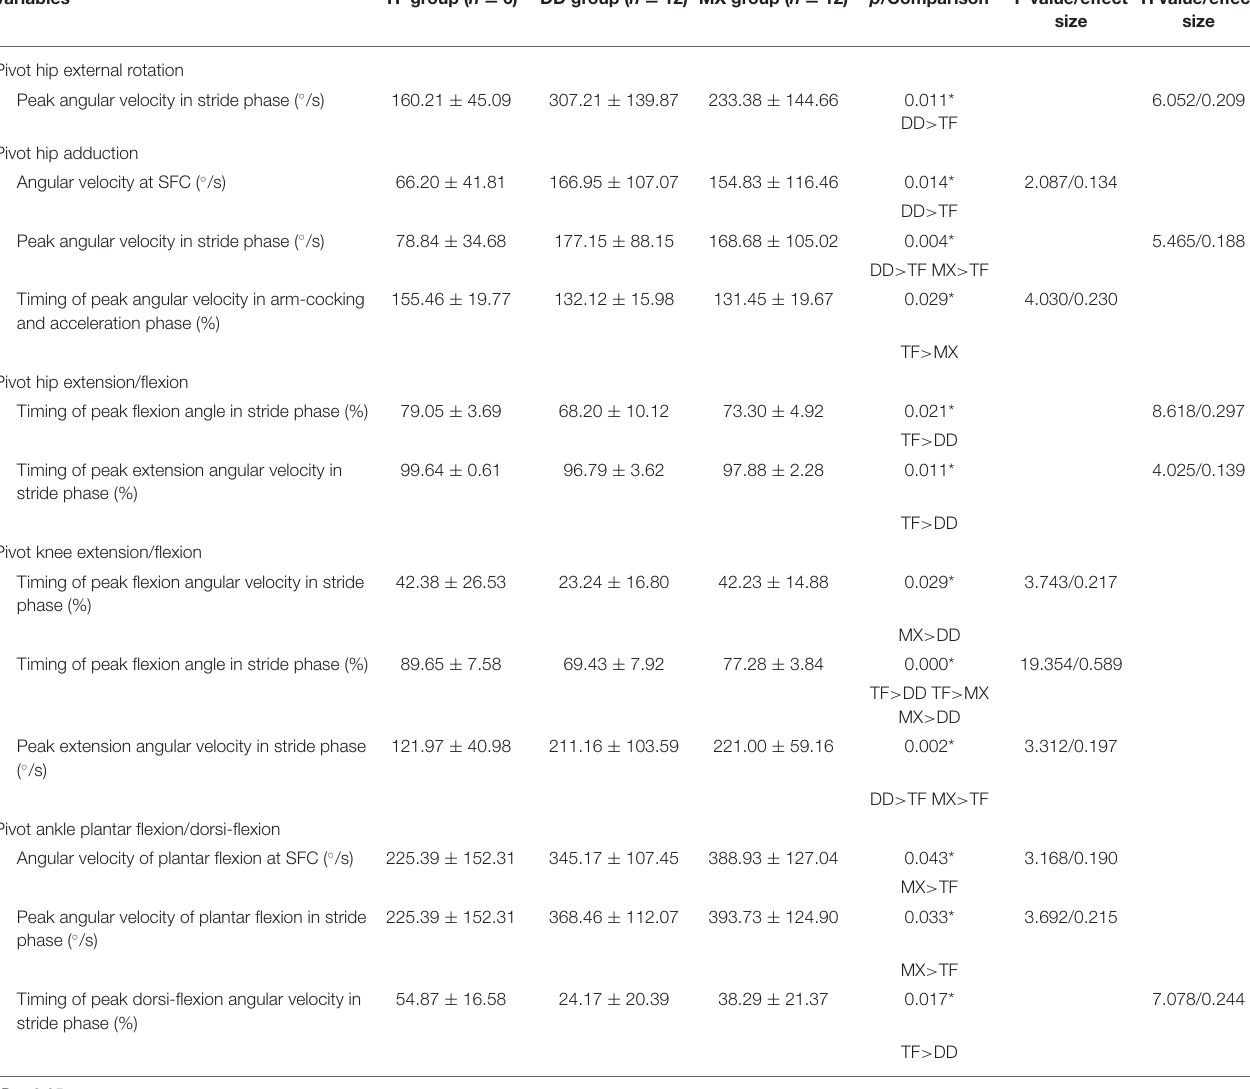
TABLE 5 | Comparison of the lower-extremity angle among the three stride types.